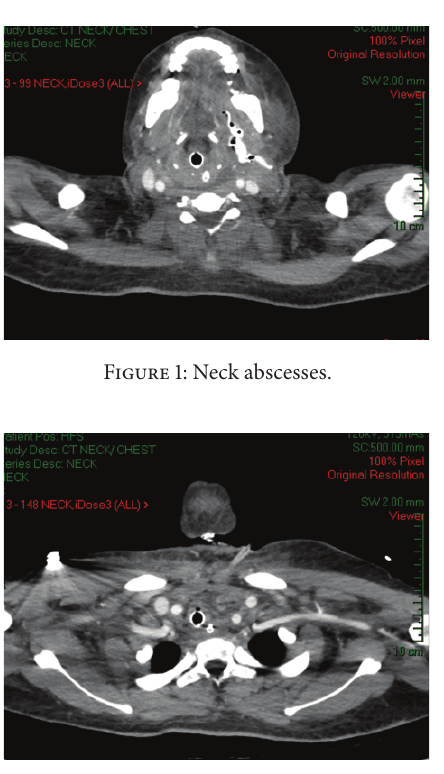
Figure 2: Mediastinal